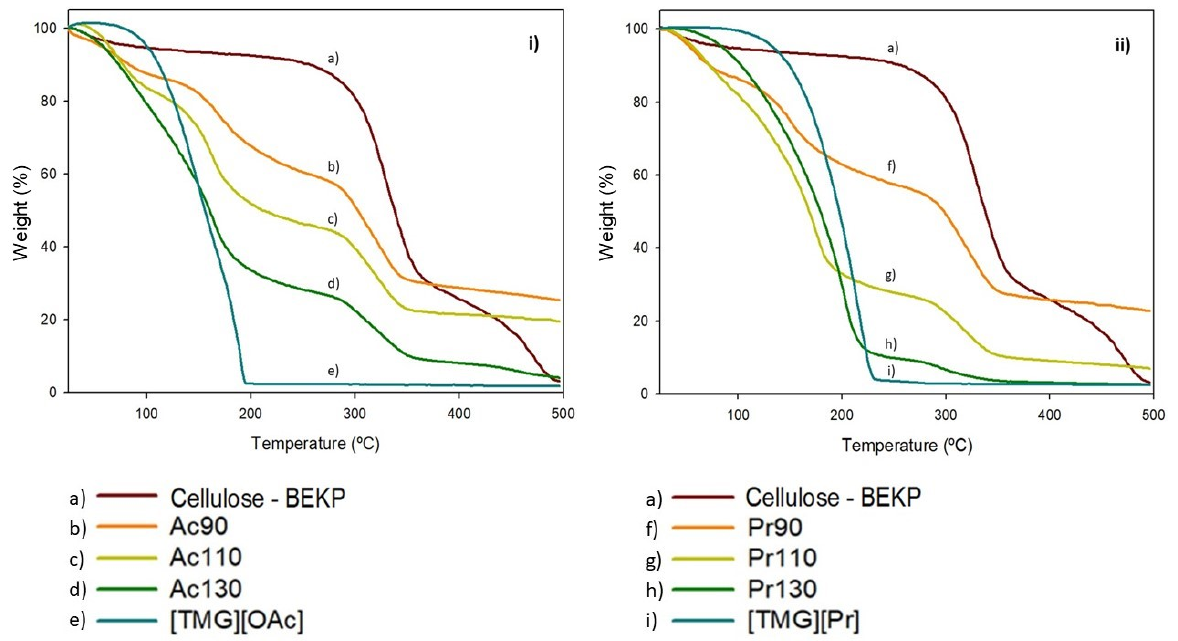
Figure 5. TGA curves of: ( i ) (a) cellulose pulp—BEKP, (b) Ac90, (c) Ac110, (d) Ac130 and (e) [TMG][OAc]; ( ii ) (a) cellulose pulp—BEKP, (f) Pr90, (g) Pr110 and (h) Pr130 and (i) [TMG][Pr]. Table 3. Thermal properties of cellulose pulp, solvents and corresponding films.